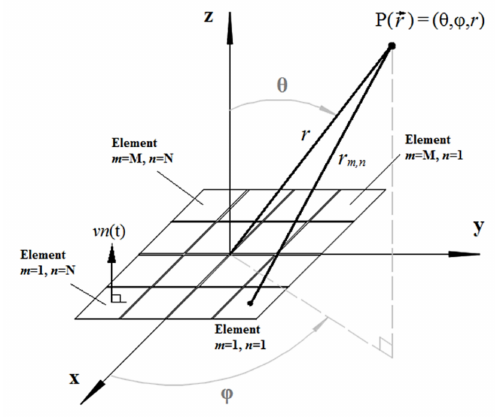
Figure 2. Geometry and coordinate system for impulse response calculation of the 2-D